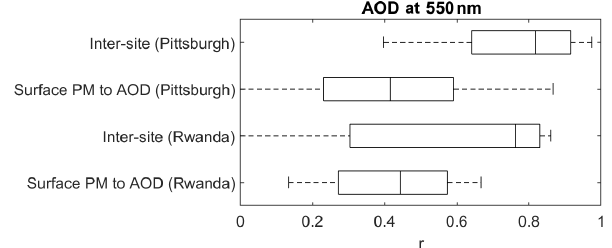
Figure 7. Comparison of inter-site correlations versus AOD-to- surface-PM 2 . 5 correlations in Pittsburgh and